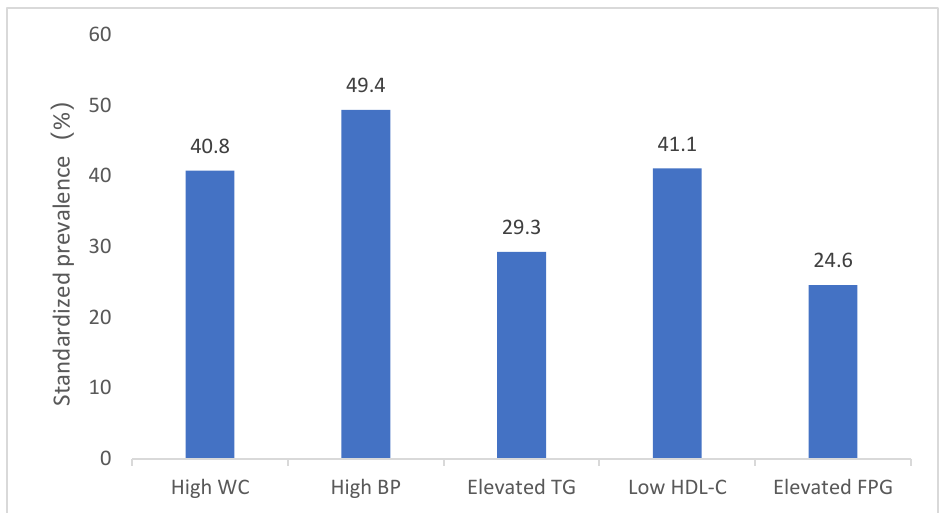
Figure 1. Standardised prevalence of metabolic components among adults in China. WC, waist circumference; BP, blood pressure; TG, triglycerides; HDL-C, high-density lipoprotein cholesterol; FPG, fasting plasma glucose.